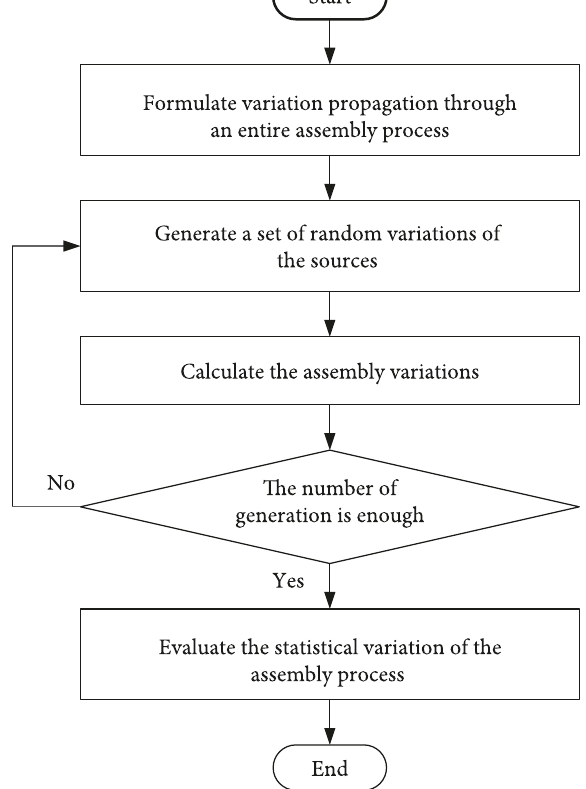
Figure 5: Flow chart of statistical variation